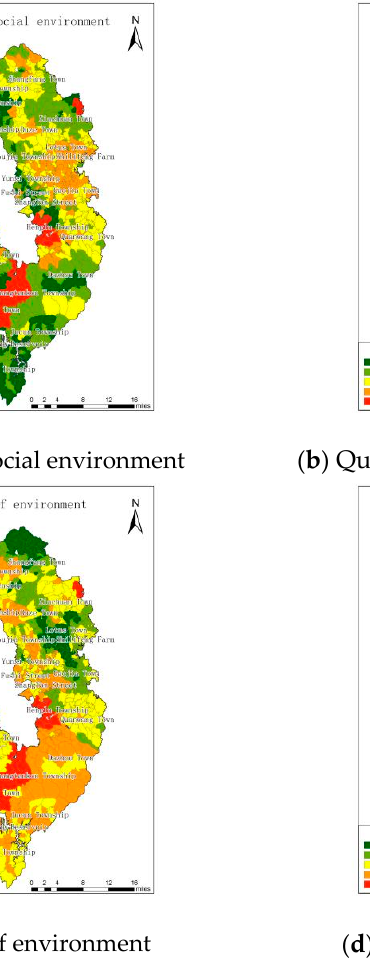
Figure 5. Social environment, natural environment and comprehensive quality evaluation results of cultivated land.